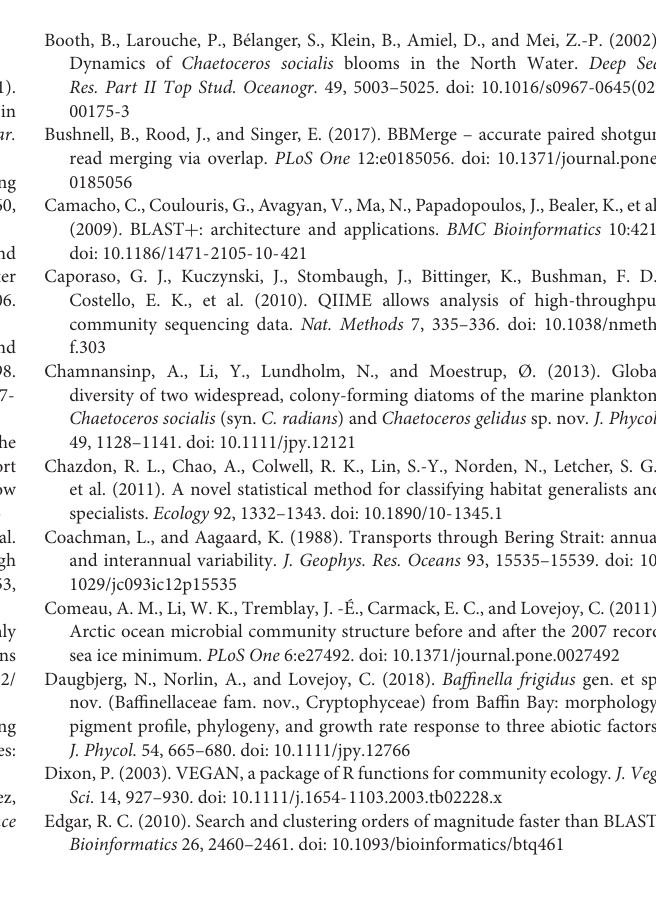
TABLE S3 | Closest BLASTn hits, origins, and references were available for the 52 OTUs indicated in Figures 6 , 7